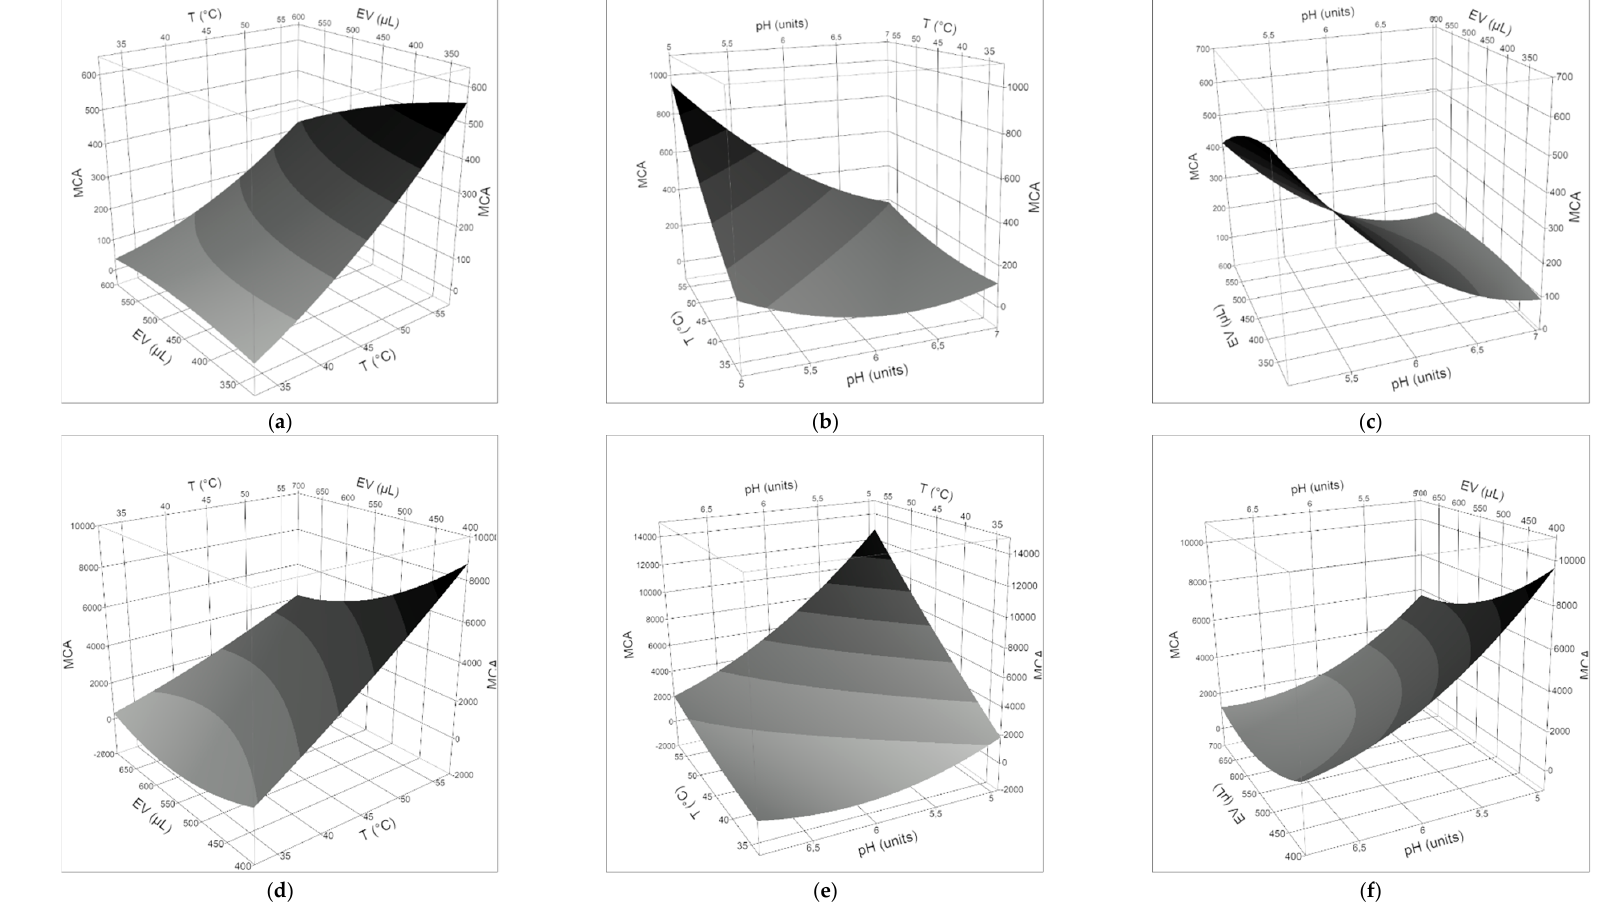
Figure 2. Response surface plots for the effects of ( a ) coagulant volume and temperature; ( b ) pH and T; ( c ) pH and coagulant volume, on the clotting activity of O. tauricum extract in ewe’s milk; ( d ) coagulant volume and temperature; ( e ) pH and T; ( f ) pH and coagulant volume, on the clotting activity of commercial rennin in ewe’s milk.